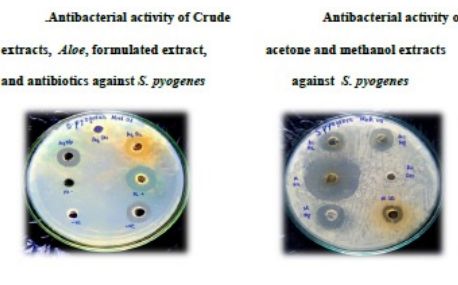
Table 2. Diameter of zone of